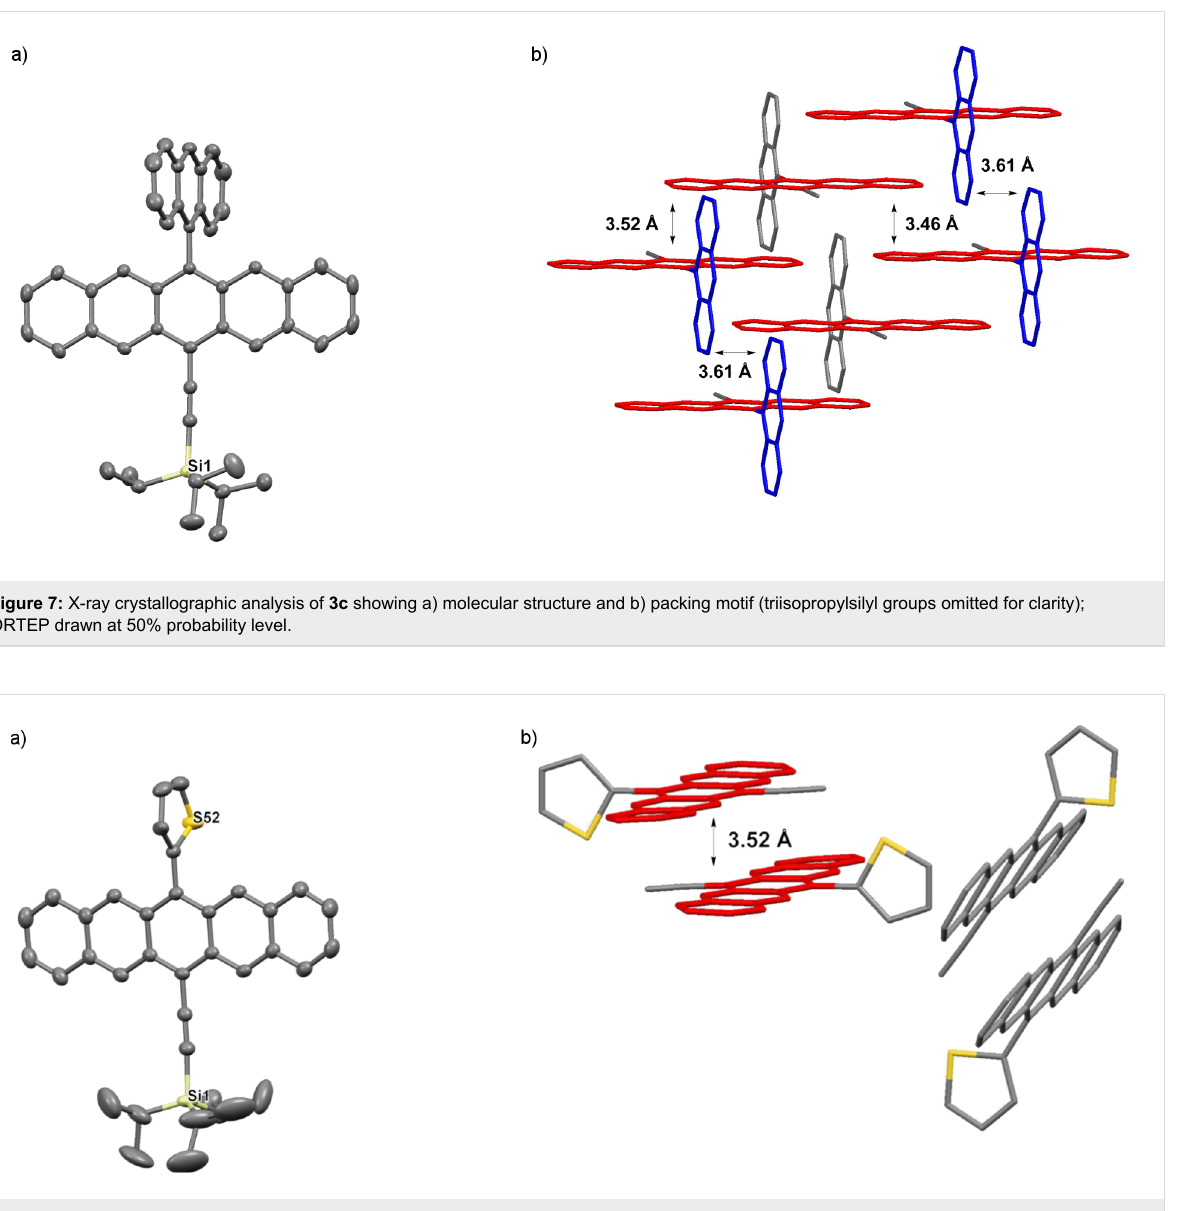
Figure 8: X-ray crystallographic analysis of 3d showing a) molecular structure, and b) packing motif (triisopropylsilyl groups omitted for clarity); ORTEP drawn at 50% probability